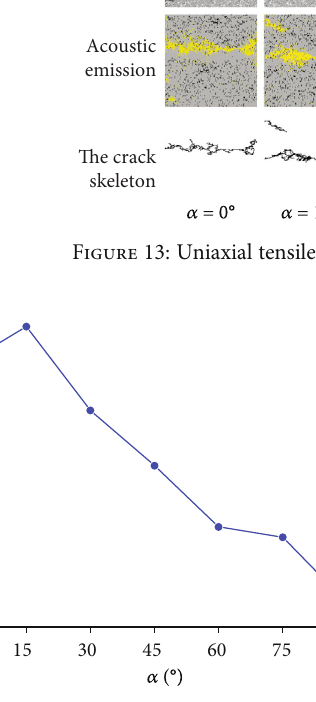
Figure 14: Relationship between fracture rate and cumulative acoustic emission of samples under di ff erent azimuth angles Table 3: Statistics of fracture rate and cumulative acoustic emission at di ff erent angles.